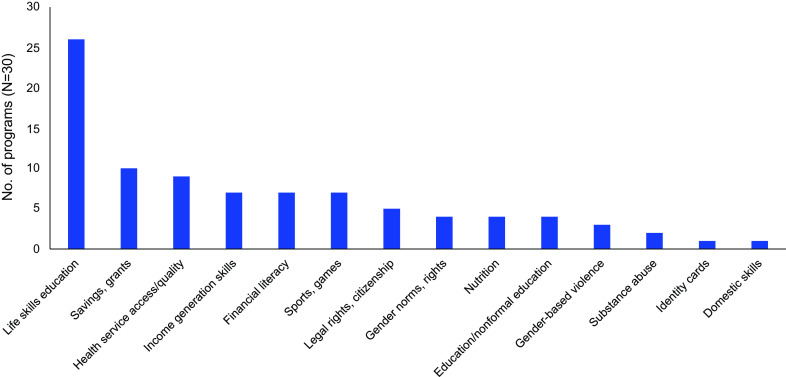
Types of Girl-Centered Content in Safe-Space Style ProgramsaaNearly all programs addressed multiple content areas.